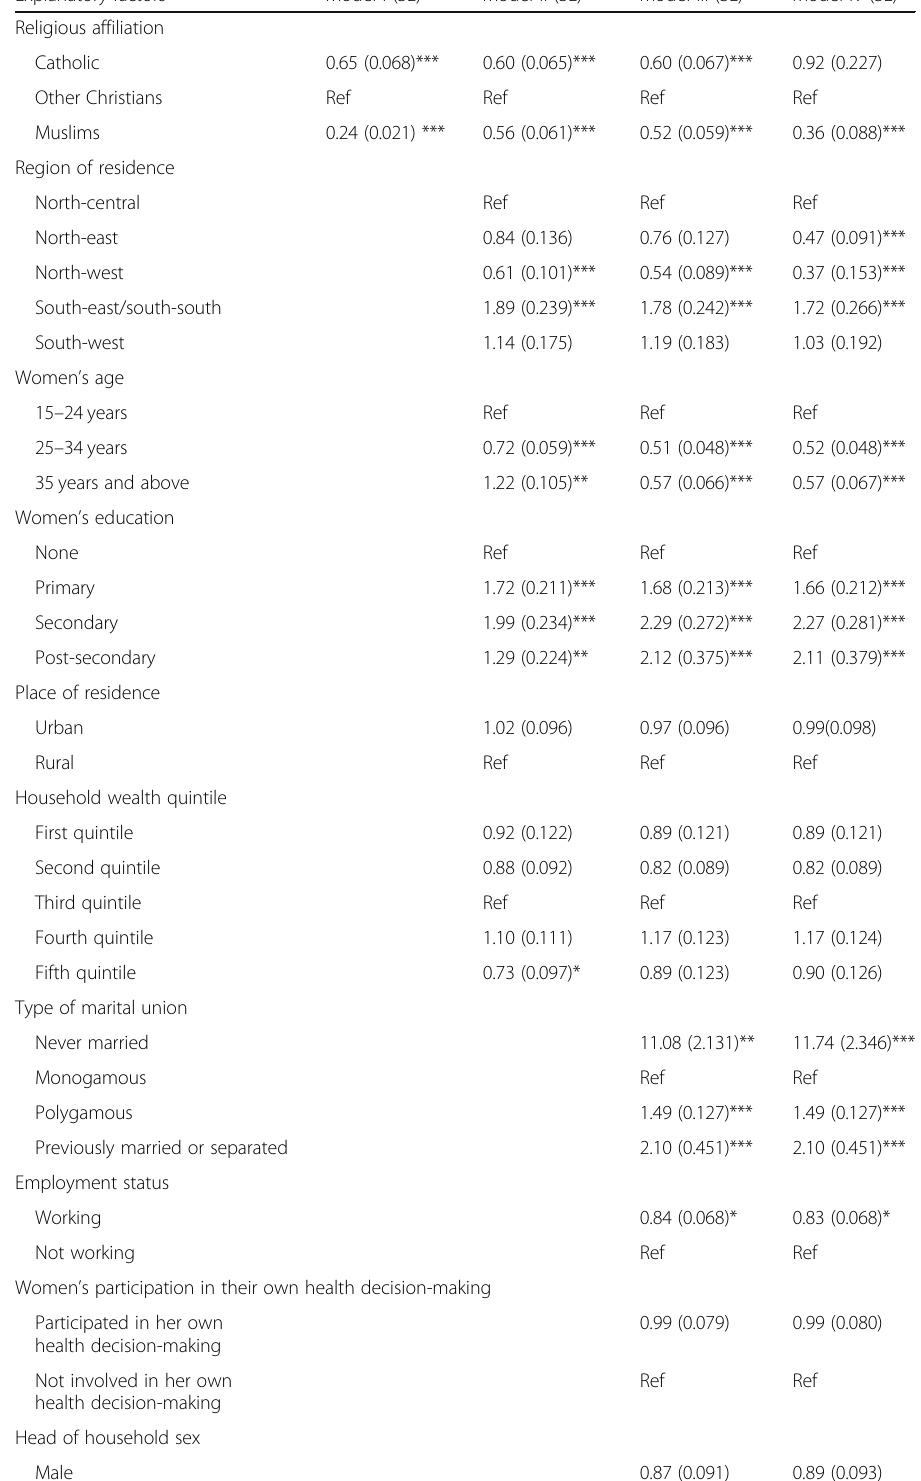
Table 3 Odds ratios of the association of unintended births with religion, region of residence, and other covariates among women in Nigeria (NDHS